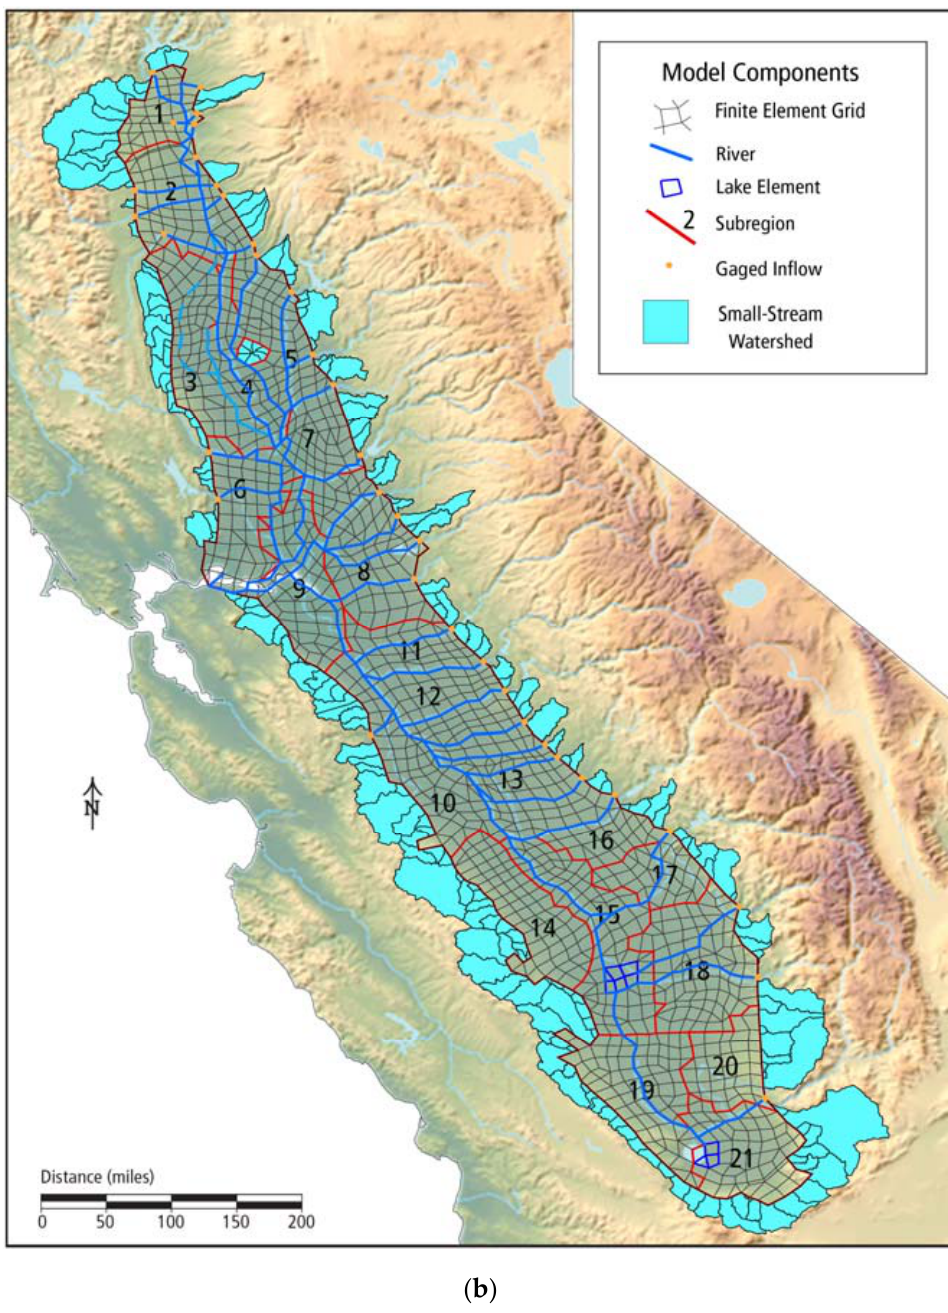
Figure 4. California’s Central Valley ( a ) major reservoirs and conveyance canals of the State Water Project (SWP) and Central Valley Project (CVP) and ( b ) California Central Valley Groundwater-Surface Water Simulation Model (C2VSim).